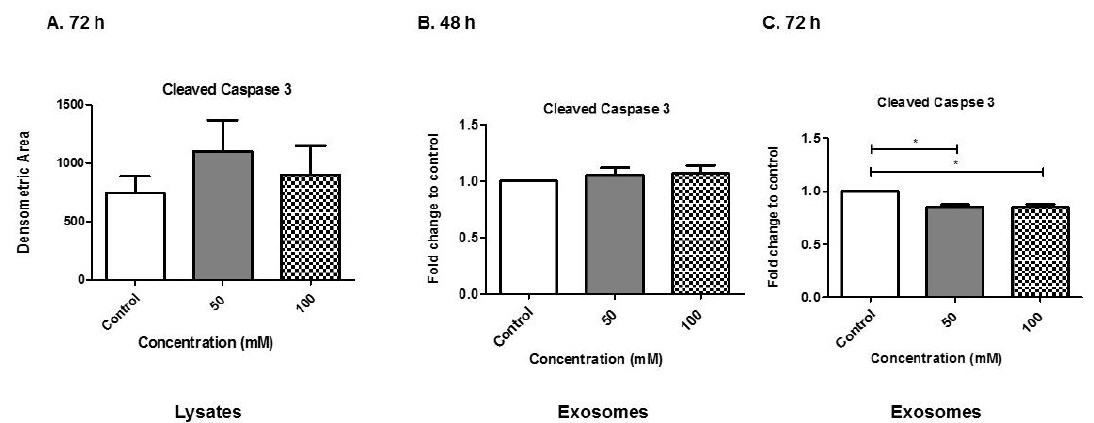
Figure 8. Cleaved caspase 3 in BV-2-derived exosomes. Cleaved caspase 3 was expressed in lysates and exosomes after EtOH dosing and detected using dot blot and ELISA. ( A ) Cell lysates (at 72 h EtOH administration) and ( B , C ) exosome proteins (at 48 and 72 h EtOH administration) were